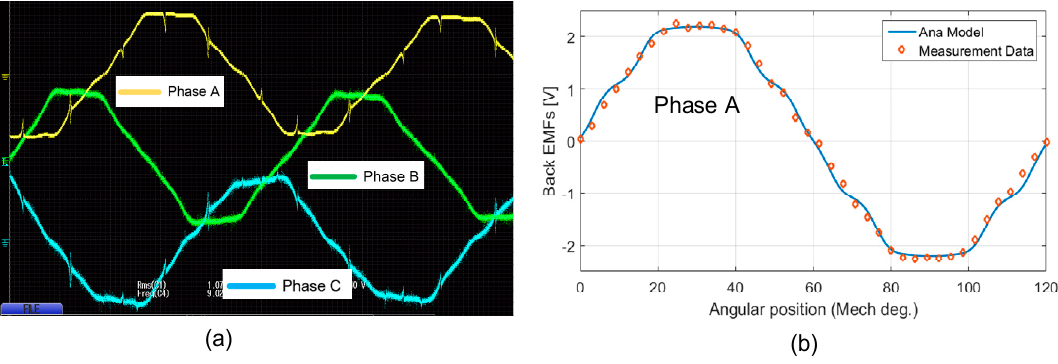
Figure 23. Experimental Back EMF waveform of AFPMMs ( a ) and the comparison with analytical model ( b ). Table 2. Comparison of Back EMF with Experiment Data.